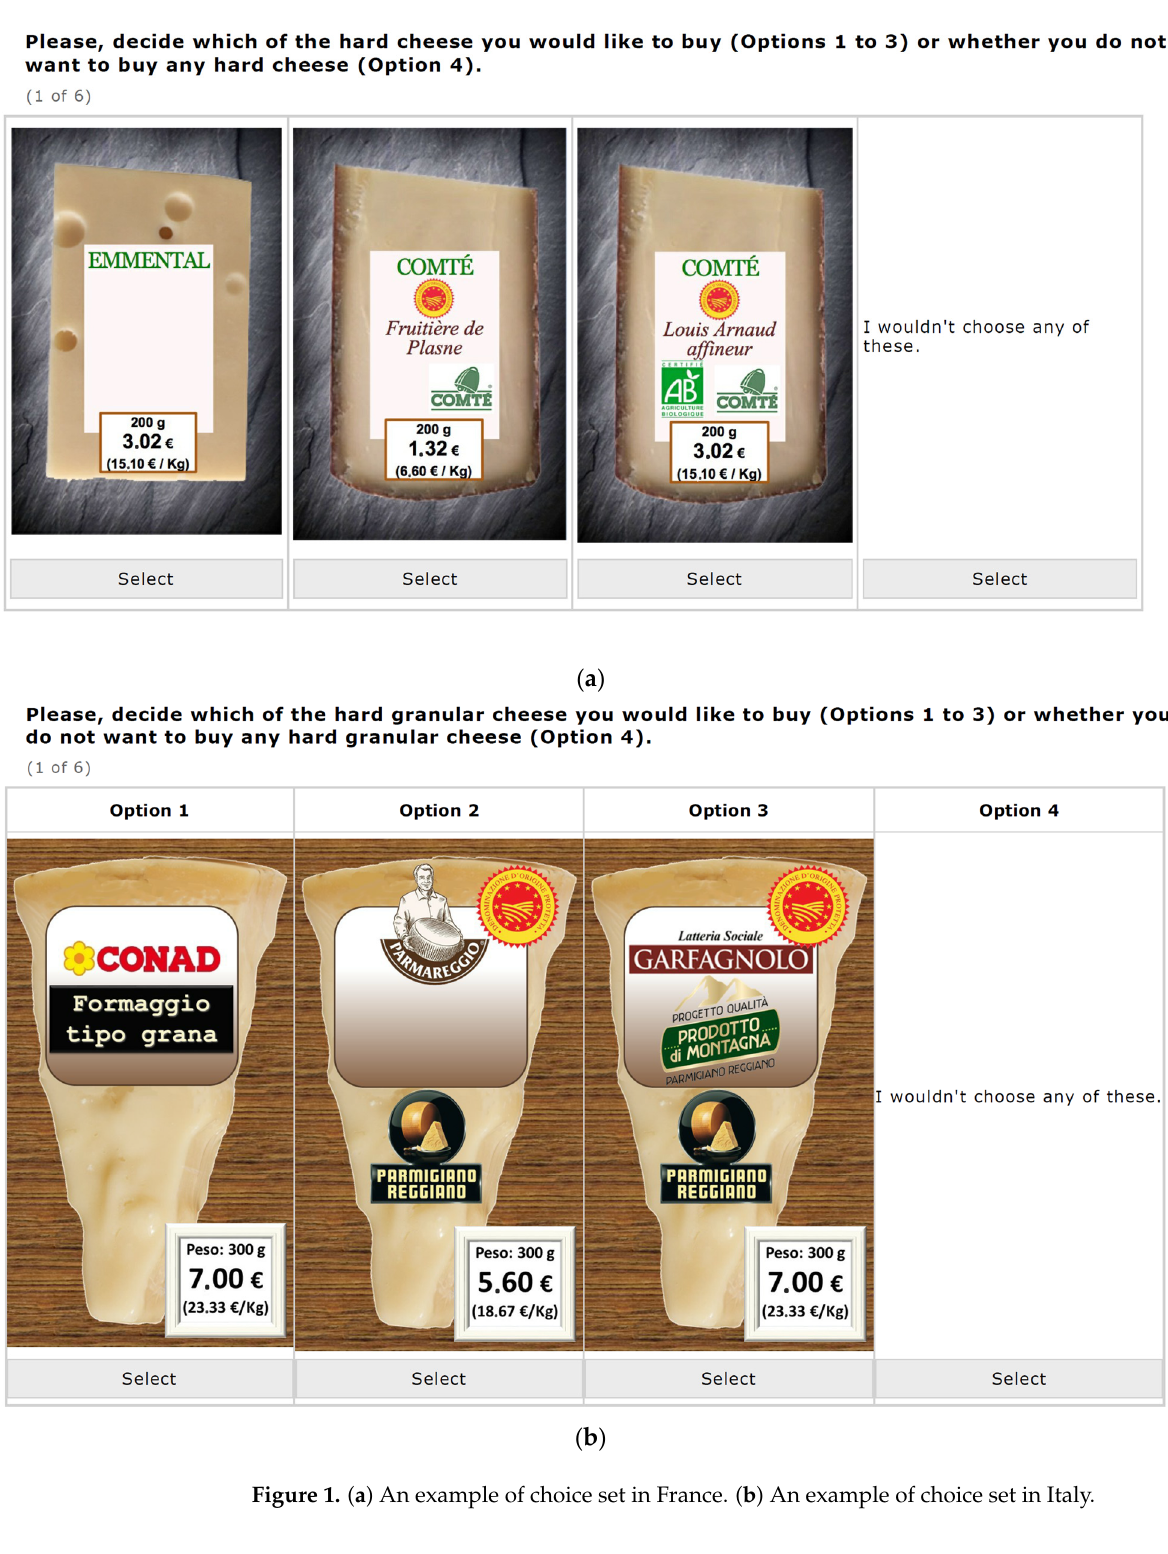
shopping, trust in quality labels (i.e., organic, PDO, the Mountain Product), as well as